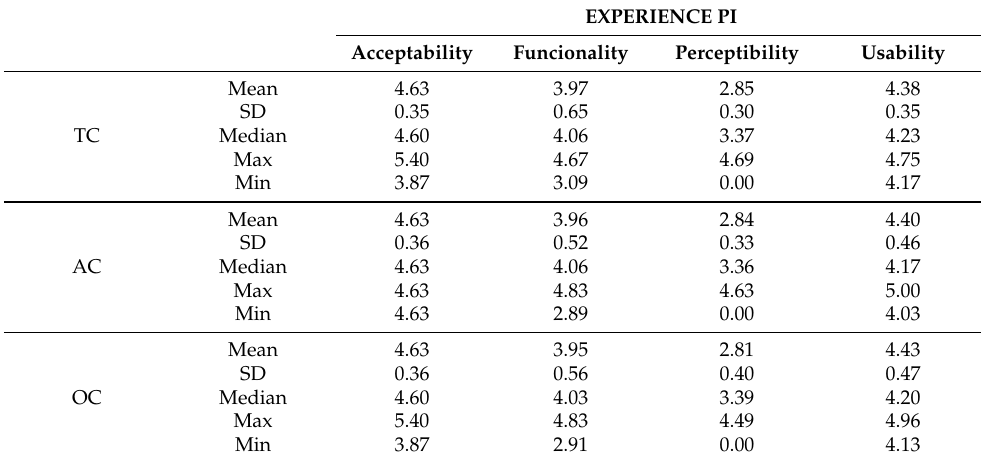
Table 5. Average and SD of questionnaire-related PIs for all subjects and walking conditions. The PI can provide values between 0 and 7 [36,37]. EXPERIENCE PI Acceptability